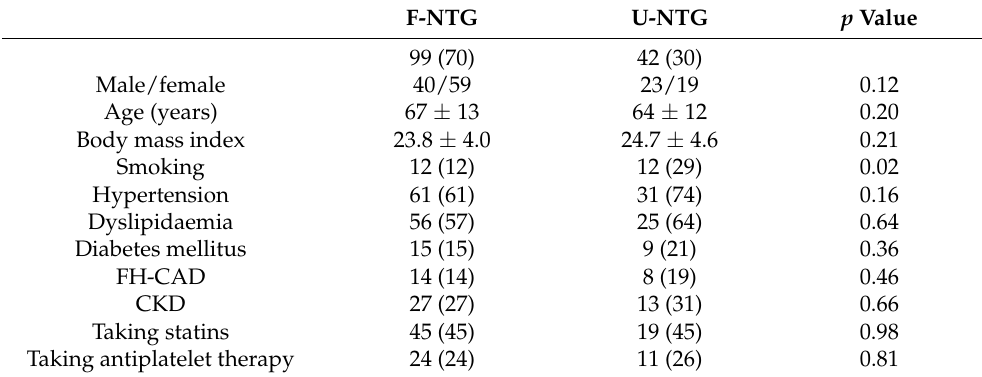
Table 1. Patients’